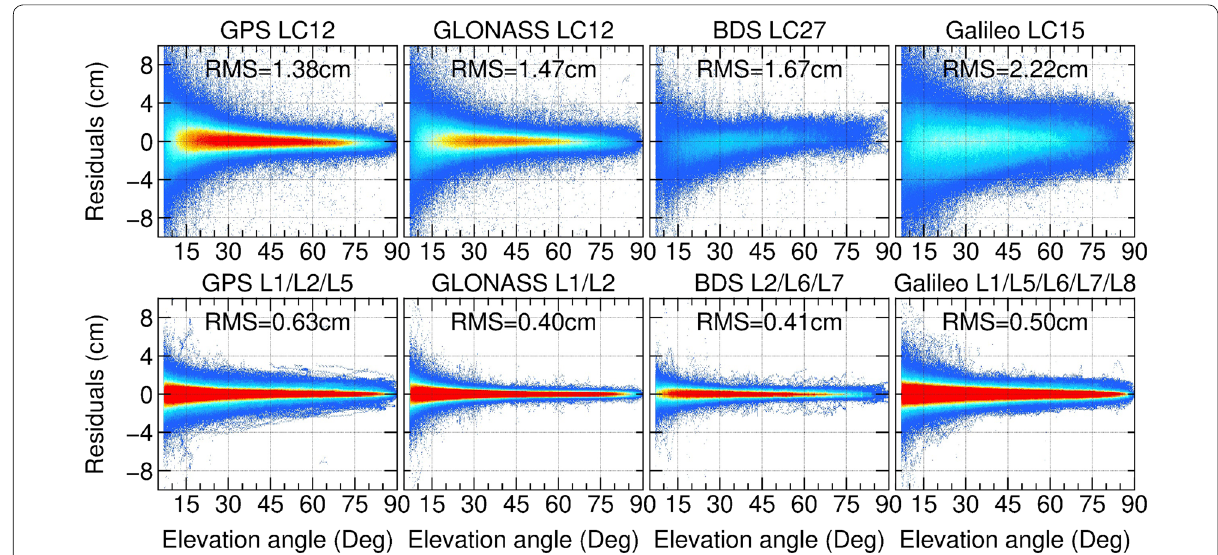
Fig. 3 Post-fit carrier-phase residuals of PPP based on raw observations and IF observations; the symbols and colors refer to the same as in Fig.